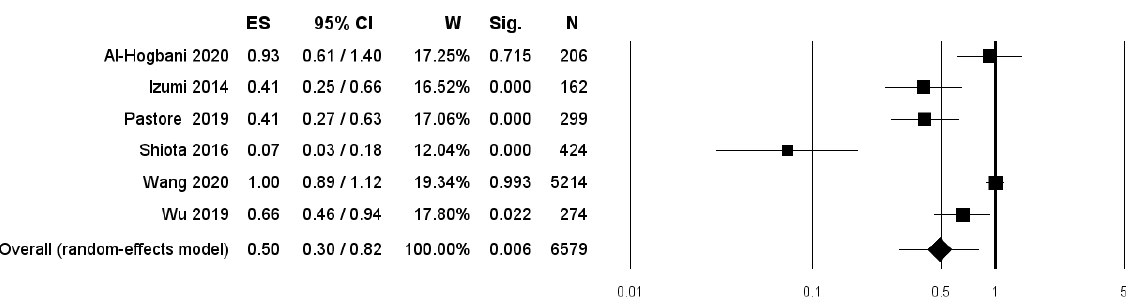
Figure 2. Forest plot showing the association between use of (5-ARIs) or androgen deprivation therapy (ADT) and the Risk Ratio (RR) of bladder cancer (BCa) recurrence. ES: Effect Size; CI: Confidence Interval. (I 2 = 91.4, p = 0.000).